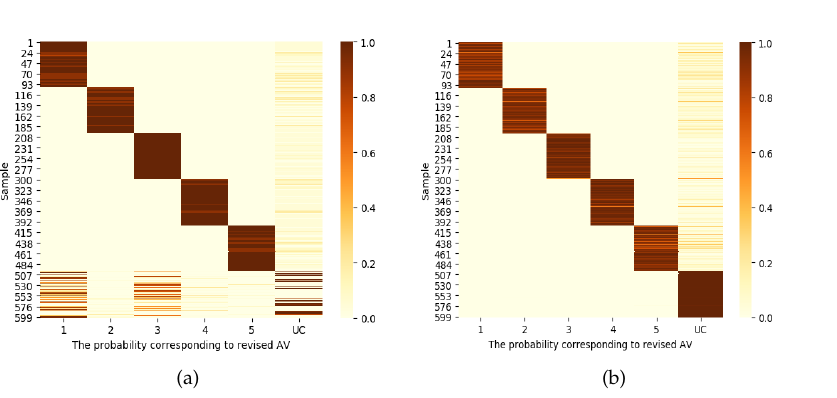
Figure 7. ( a ) Visualization of the revised AV probability distribution before improvement. ( b ) Visual- ization of the revised AV probability distribution after